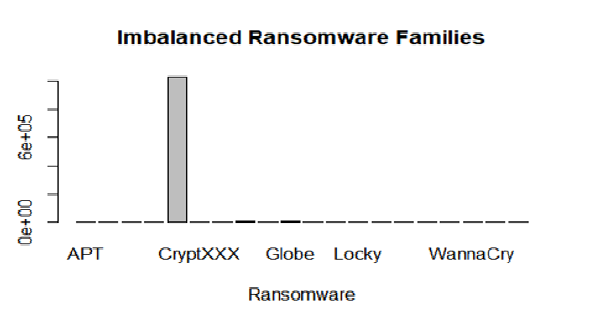
Figure 11. Imbalanced features of the ransomware dataset. APT stands for Advanced Persistent